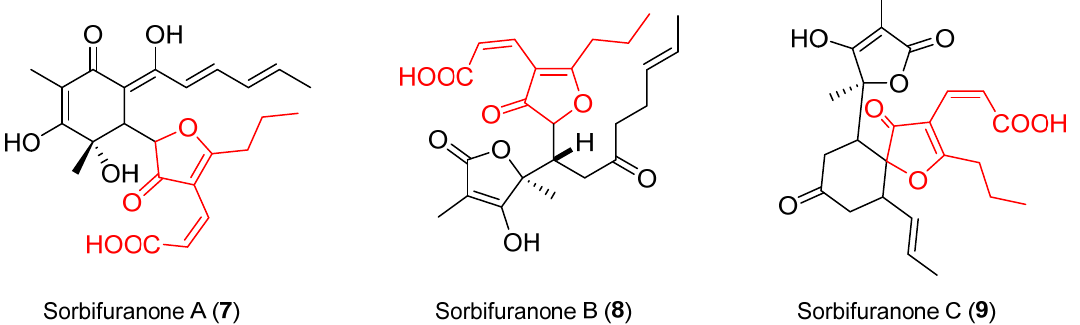
Figure 2. Sorbifuranone A ( 7 ), sorbifuranone B ( 8 ), sorbifuranone C ( 9 ), with (2 Z )-cillifuranone fragments highlighted in red.